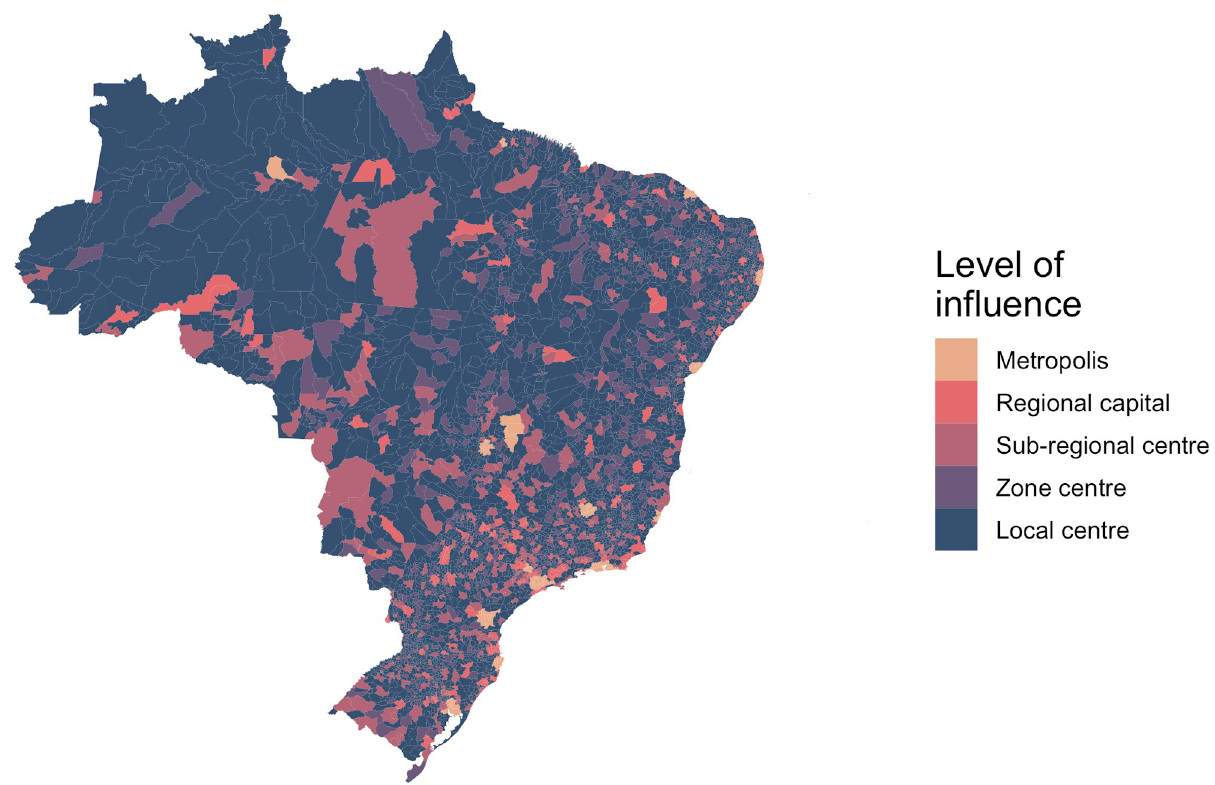
Fig 2. The level of influence of cities within the Brazilian urban network from REGIC 2018. The Amazon region is far less connected to the urban network than the rest of the country. As there is only one metropolis in North Brazil (Manaus), people often travel great distances, far greater than in other regions, to reach cities. Maps were produced in R using the geobr package [32,35] (https://ipeagit.github.io/geobr/).